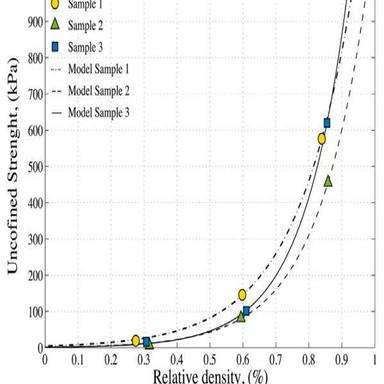
Unconfined compression for three samples at Diablo Regimiento mine .